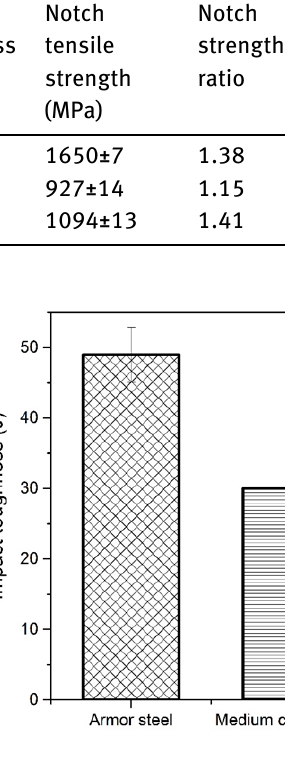
Figure 8: Impact toughness of base metals and dissimilar